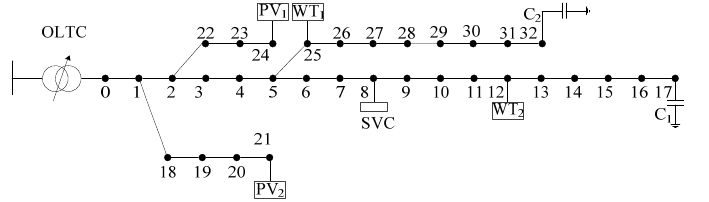
Figure 9. Topology of modified IEEE 33-bus radial distribution network with renewable energy sources.